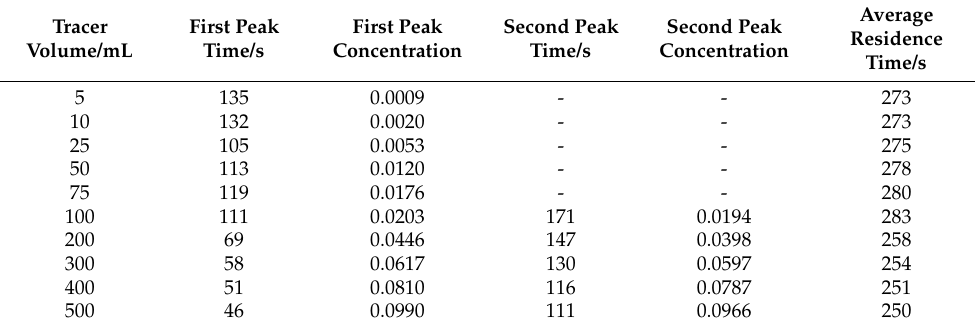
Table 8. RTD curves analysis results in the case of different tracer solution volumes. Tracer